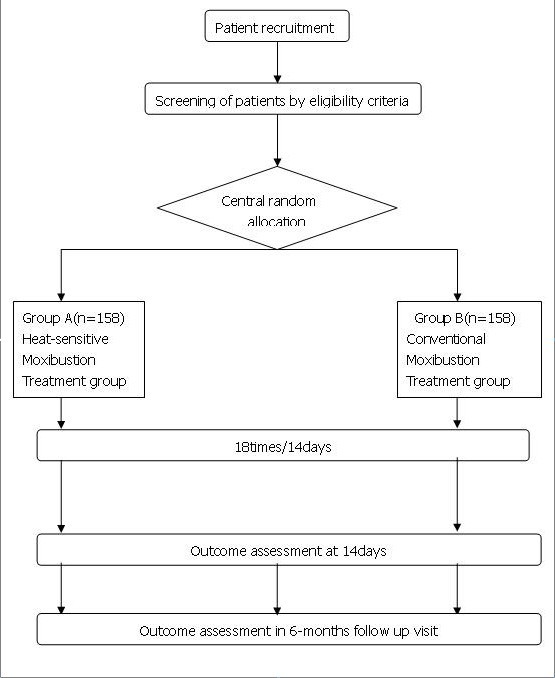
Test flow chart.